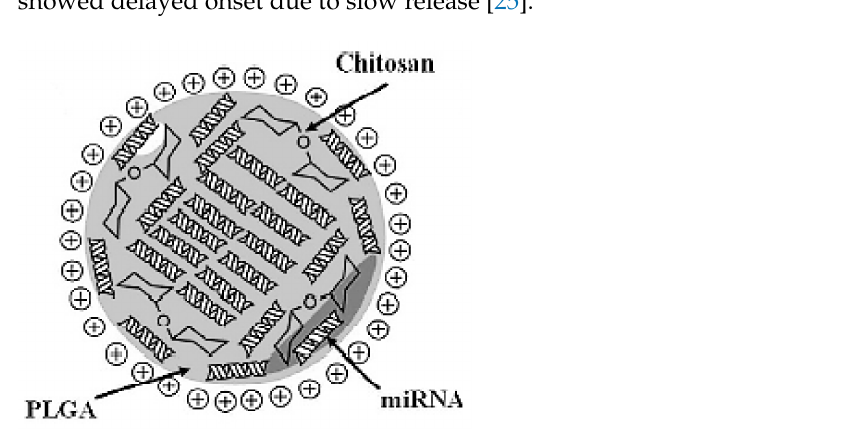
Figure 4. Schematic representation of miRNA-34a-loaded chitosan/PLGA nanoplexes. (Reproduced from [35]). This work is licensed under a Creative Commons Attribution 4.0 International License.